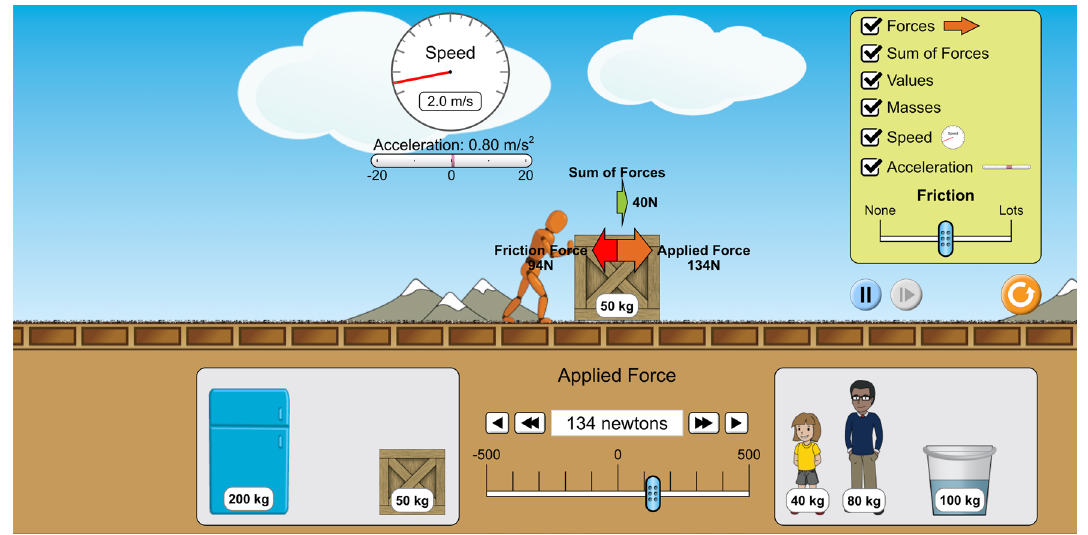
Fig. 2 Snapshot of the Acceleration